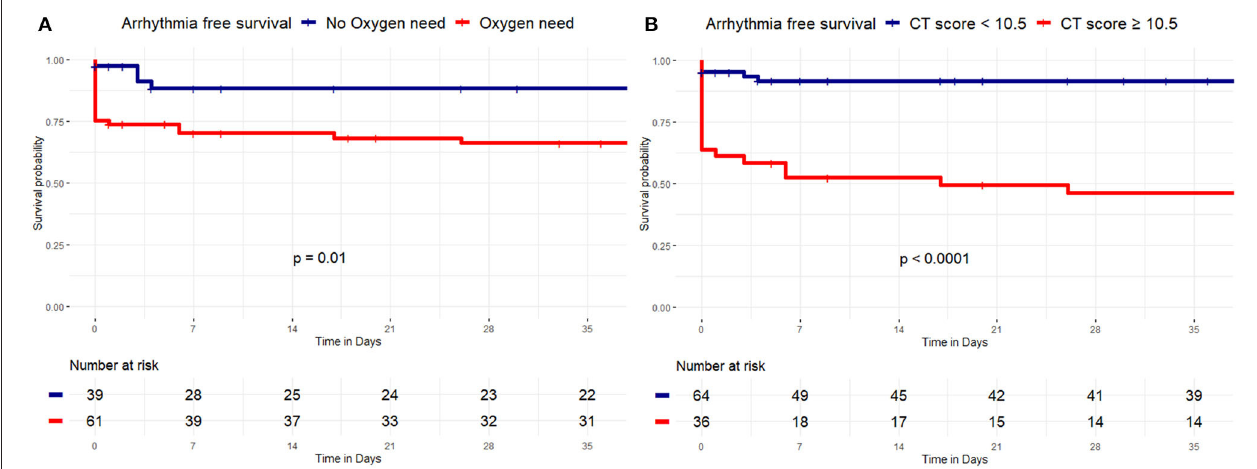
FIGURE 2 | Kaplan-Meier curves of survival free from arrhythmia occurrence by oxygen need and a CT severity score. Kaplan-Meier curve of survival free from arrhythmias by oxygen therapy need and a CT severity score. (A) Patients with no oxygen therapy need (blue curve) had higher VA free survival during the follow-up, compared with patients with oxygen therapy need (red curve), (89.7 vs. 65.6%, Log-Rank p = 0.01). (B) Patients with CT severity score < 10.5 (blue curve) had higher VA free survival during the follow-up, compared with patients with CT severity score ≥ 10.5 (red curve), (90.6 vs. 47.2%, Log-Rank p < 0.001).